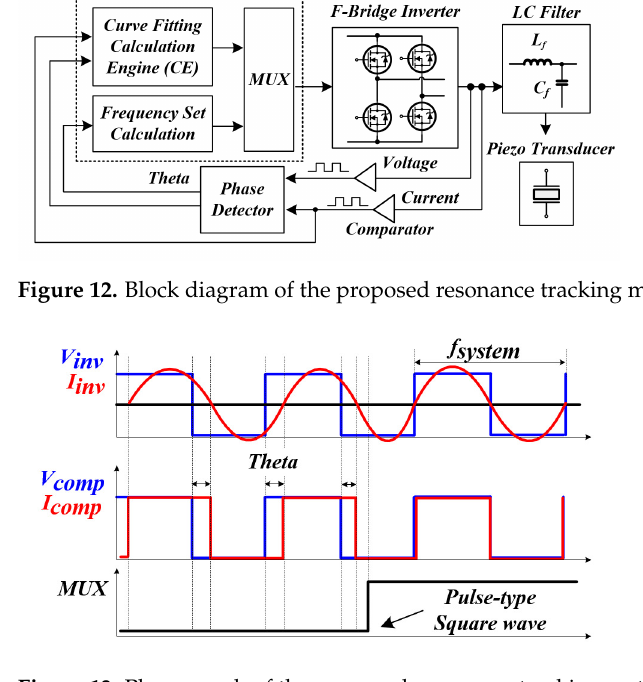
Figure 13. Phase graph of the proposed resonance tracking method according to the time change.